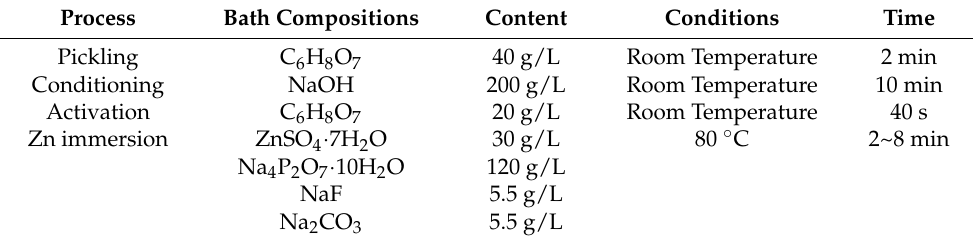
Table 1. The solution compositions and operation conditions of Zn immersion. Process Bath Compositions Content Conditions Time Pickling C 6 H 8 O 7 Room Temperature 2 min Conditioning NaOH 200 g/L Room